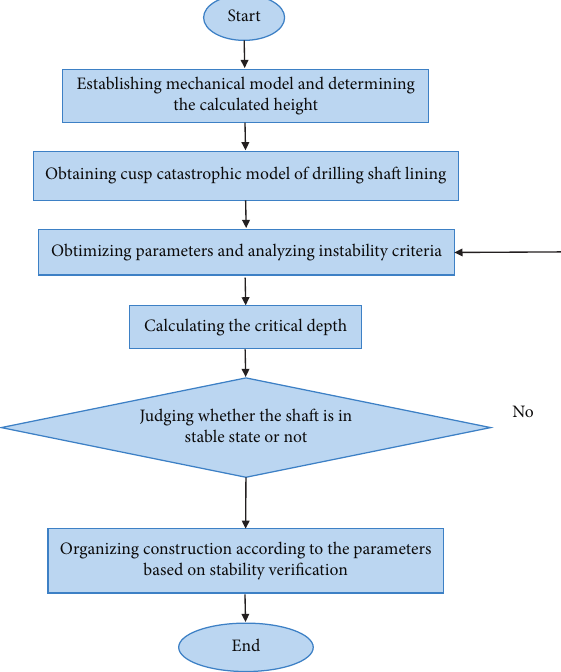
Figure 5: Flow chart of vertical stability analysis of drilling shaft lining by catastrophe